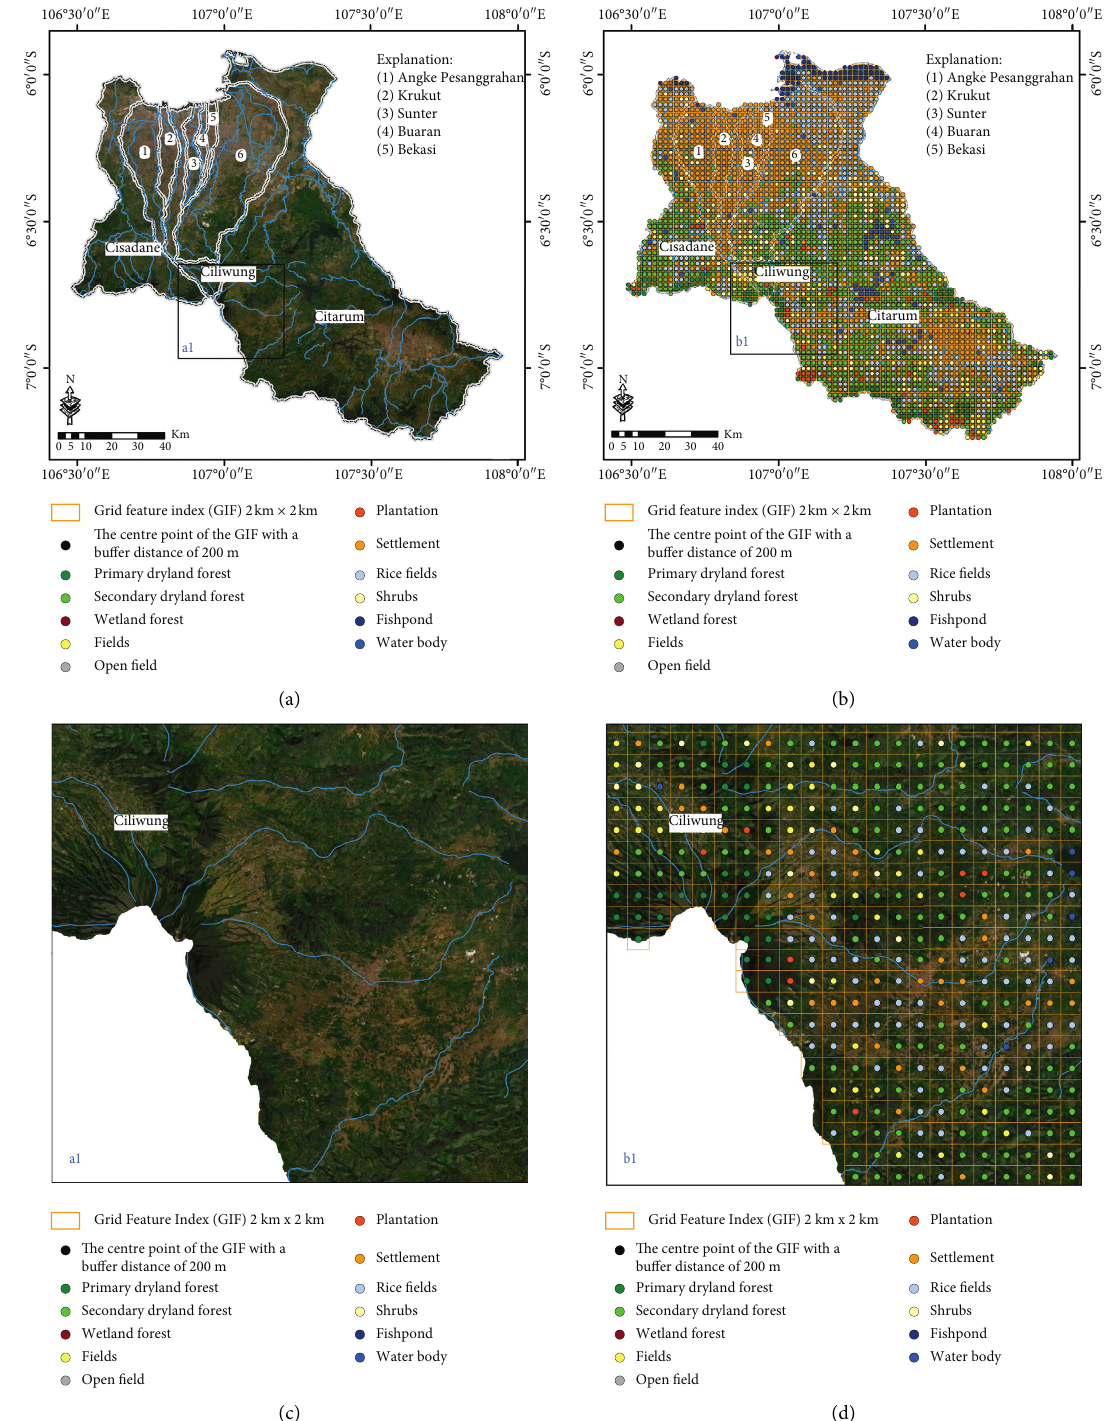
Figure 3: Determination of training samples and reference map of the study area: (a, c) annual mosaic of SPOT 6/7 images in 2019; (b) compilation of the Grid Feature Index (GIF) with dimensions of 2 km × 2km is carried out to determine training samples and LULC. references; (d) centre point of each GIF block buffered with a distance of 200 m is used as the location for training samples and references from LULC